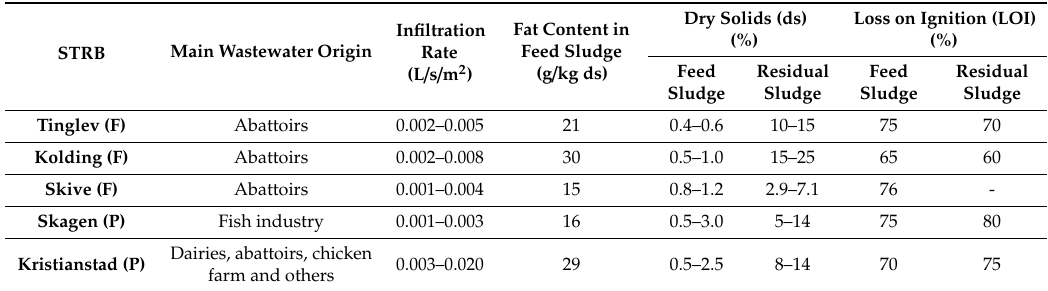
Table 2. Dewatering e ffi ciency of various STRBs in Denmark and Sweden treating sludge with high fat contents (P = pilot, F =